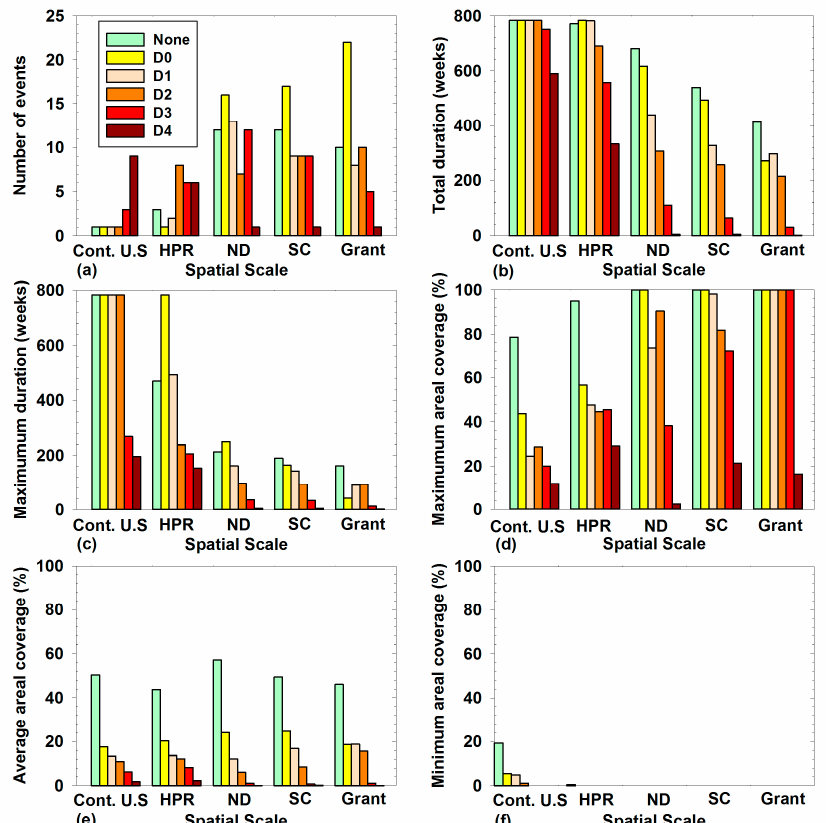
Figure 6. Comparing spatial scales with: ( a ) The number of events; ( b ) the total duration (weeks); ( c ) the maximum duration (weeks); ( d ) the maximum areal coverage; ( e ) the average areal coverage; and ( f ) the minimum areal coverage for each intensity category and “none” condition.